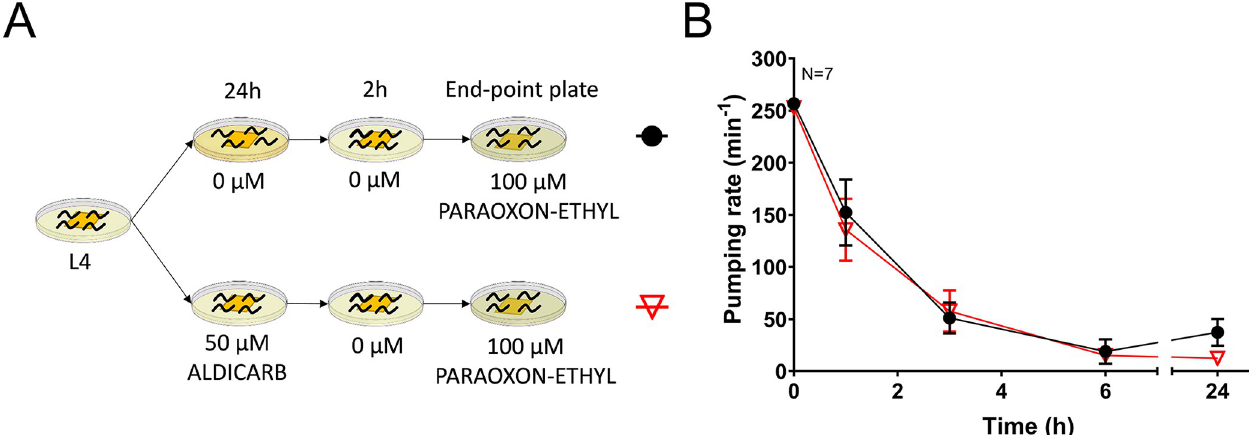
Fig 3. Aldicarb-preconditioned and non-preconditioned nematodes exhibit a similar pharyngeal function when subsequently exposed to paraoxon-ethyl. A) Synchronized L4 worms were incubated on either vehicle control or 50 μ M aldicarb plates for 24 hours. After recovery on non-drug containing plates, they were exposed to 100 μ M paraoxon-ethyl and pumping was measured. B) Aldicarb pre-exposed nematodes exhibit a similar sensitivity to paraoxon-ethyl as non-preconditioned worms. Data are shown as mean ± SEM of 7 worms in at least 4 independent experiments (N = 7).